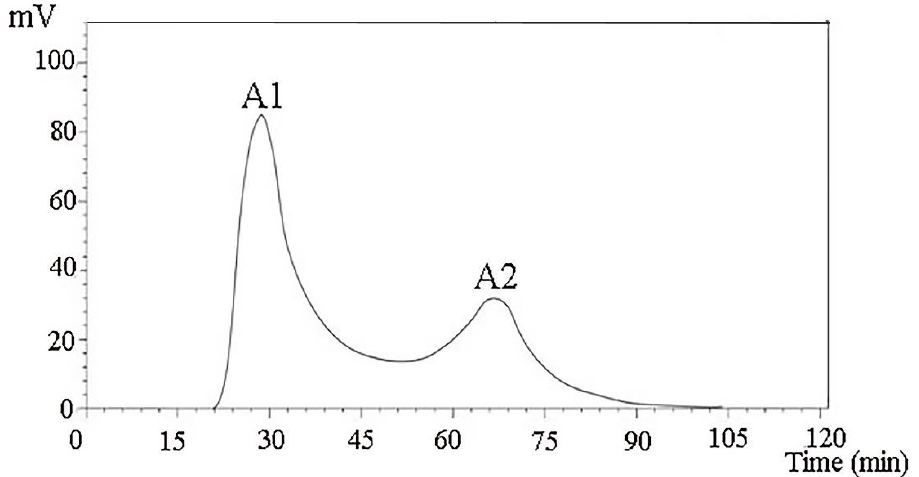
Figure 1. Purification spectra of peptides from Camella vietnamensis meal by DEAE Sepharose F.F.